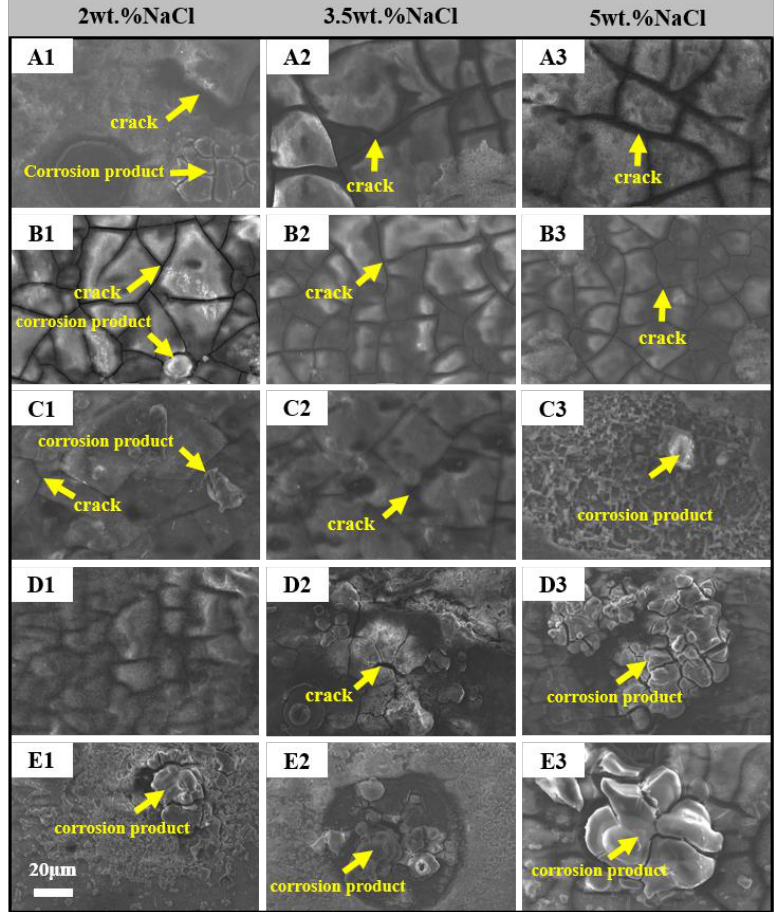
Figure 6. The microscopic morphology of specimens immersed in different concentrations of NaCl solution for 14 days (( A1 – A3 ): 2A97-T3; ( B1 – B3 ): 2A97-T6; ( C1 – C3 ): 2024-T4; ( D1 – D3 ): 2060-T8; ( E1 – E3 ): 2099-T83).